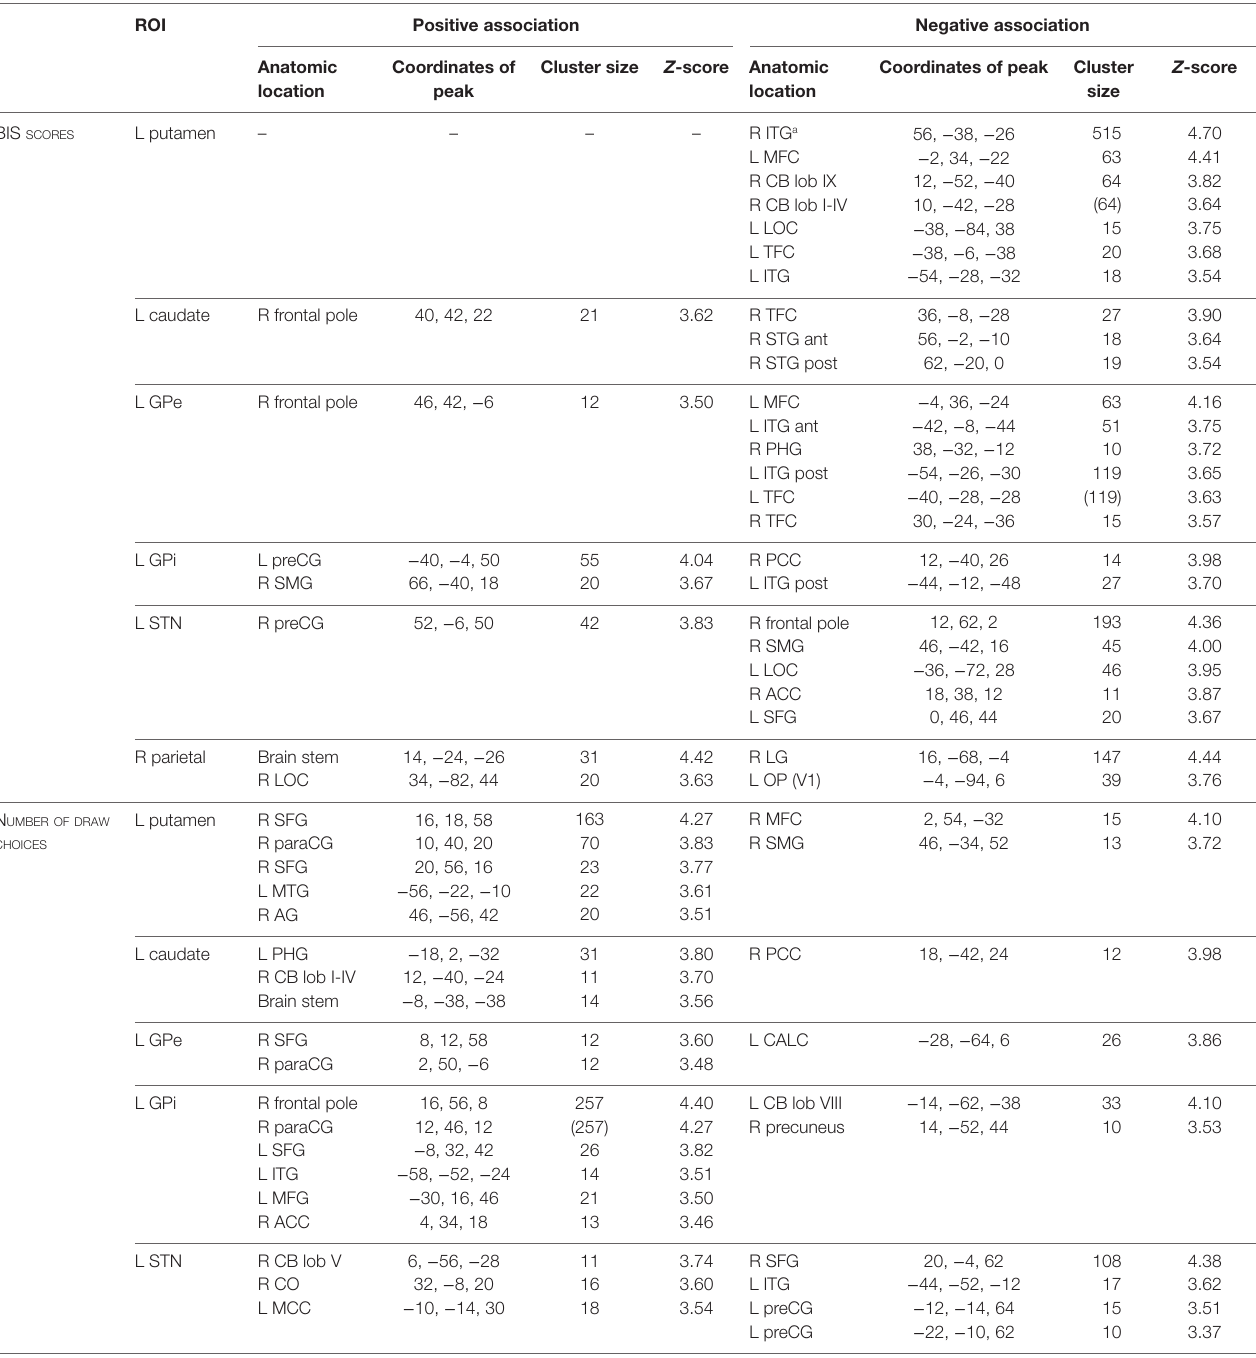
Cluster sizes between parentheses denote a second peak within the same cluster as listed in the row immediately preceding. GPe/GPi, external/internal portion of the globus pallidus; STN, subthalamic nucleus; ITG, inferior temporal gyrus; MFC, medial frontal cortex; CB, cerebellum; LOC, lateral occipital cortex; TFC, temporal fusiform cortex; STG ant/post, superior temporal gyrus, anterior/posterior division; ITG ant/post, inferior temporal gyrus, anterior/posterior division; PHG, parahippocampal gyrus; preCG, precentral gyrus; SMG, supramarginal gyrus; PCC, posterior cingulate cortex; ACC, anterior cingulate cortex; SFG, superior frontal gyrus; LG, lingual gyrus; OP, occipital pole; V1, primary visual area; paraCG, paracingulate gyrus; MTG, middle temporal gyrus; AG, angular gyrus; CALC, calcarine cortex; MFG, middle frontal gyrus; CO, central operculum; MCC, middle cingulate